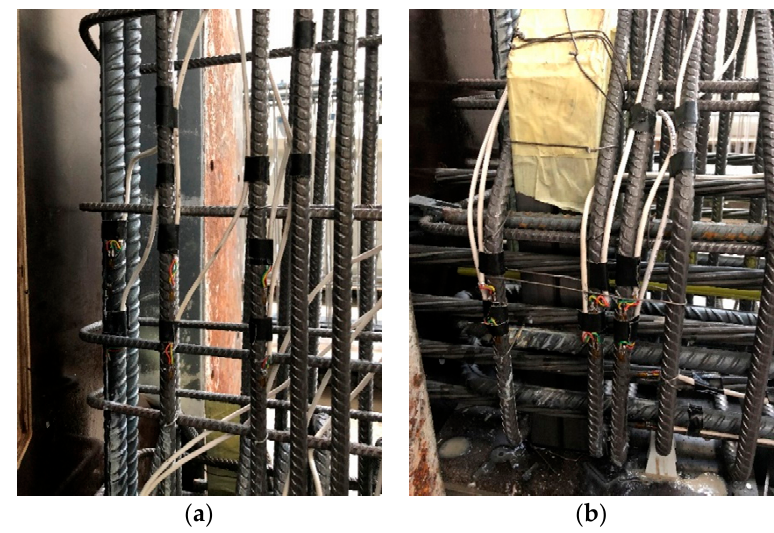
Figure 4. Strain gauges on the rebars: ( a ) Web rebar; ( b ) Bottom flange rebar.